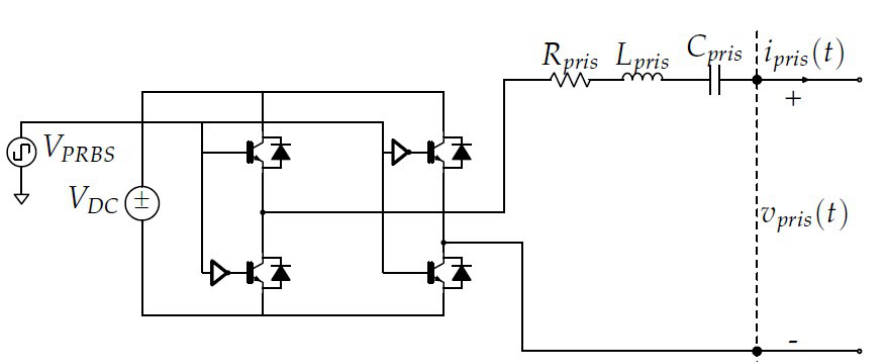
Figure 2. PRIS Test Arrangement to Perturb the Three-Section Winding Model.